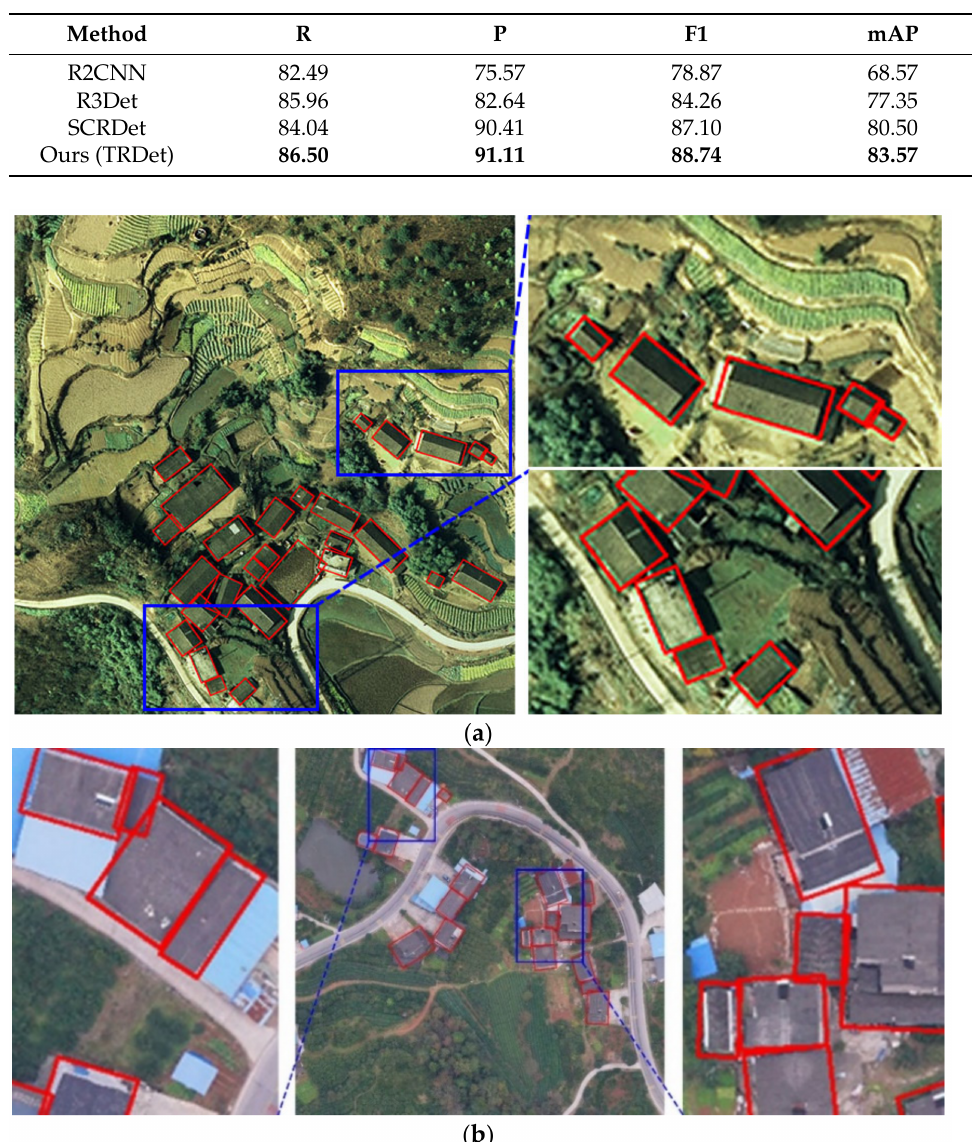
Figure 9. Example of TRDet model detection results: ( a ) image for the rural building in Zigui; ( b ) image for the rural building in